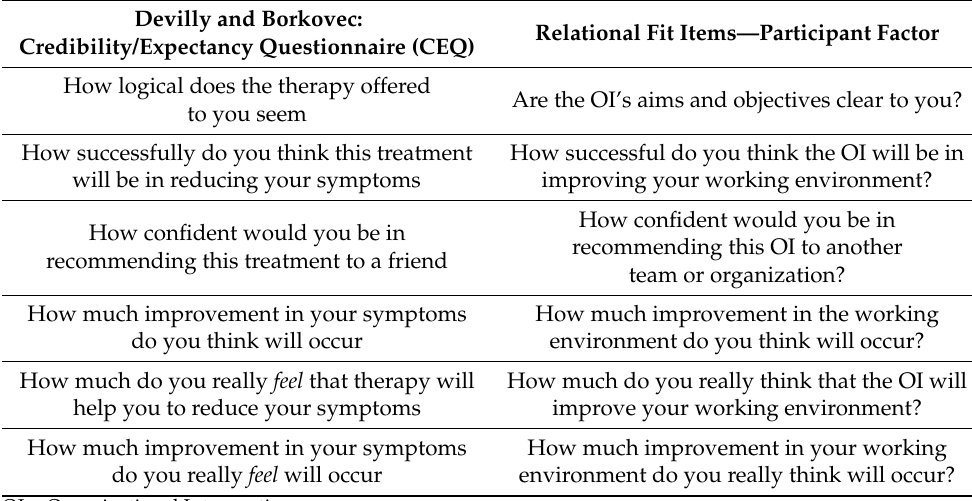
Table 2. (Re)conceptualization of the CEQ into relational fit: Participant factors. Devilly and